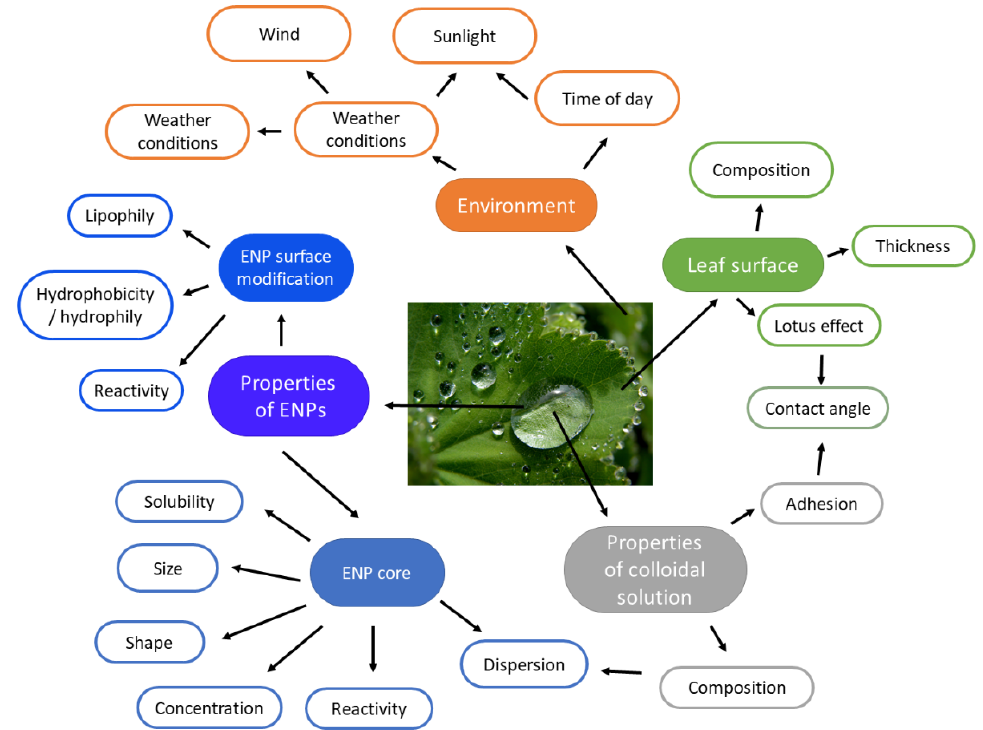
Figure 1. Properties affecting the application of ENPs on leaves in field conditions. Table 1. Effects of ZnO NPs in higher plants grown under the field